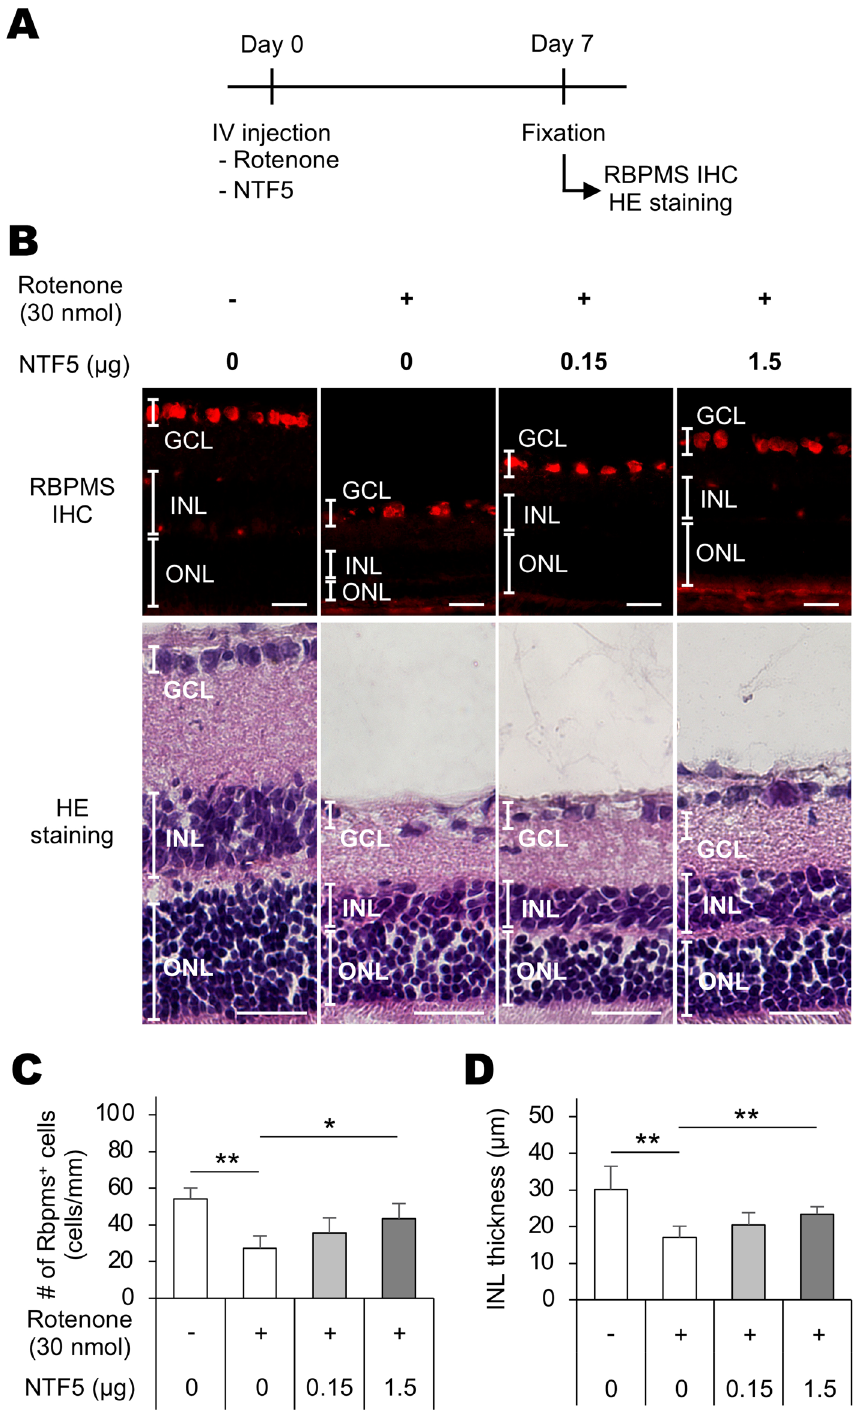
Figure 5. Effects of intravitreal administration of NTF5 proteins on rotenone-induced retinal degeneration in rats. ( A ) Schematic of the experimental procedure. ( B ) RBPMS immunohistochemistry (IHC) and hematoxylin/ eosin (HE) staining of retinal sections prepared from animals intravitreally treated with rotenone and NTF5 recombinant proteins. ( C, D ) Quantification of the number of RBPMS + RGCs ( C ) and thickness of the INL in rotenone- and NTF5-administrated rats. RBPMS, RNA-binding protein with multiple splicing; RGC, retinal ganglion cell. Scale bars: 50